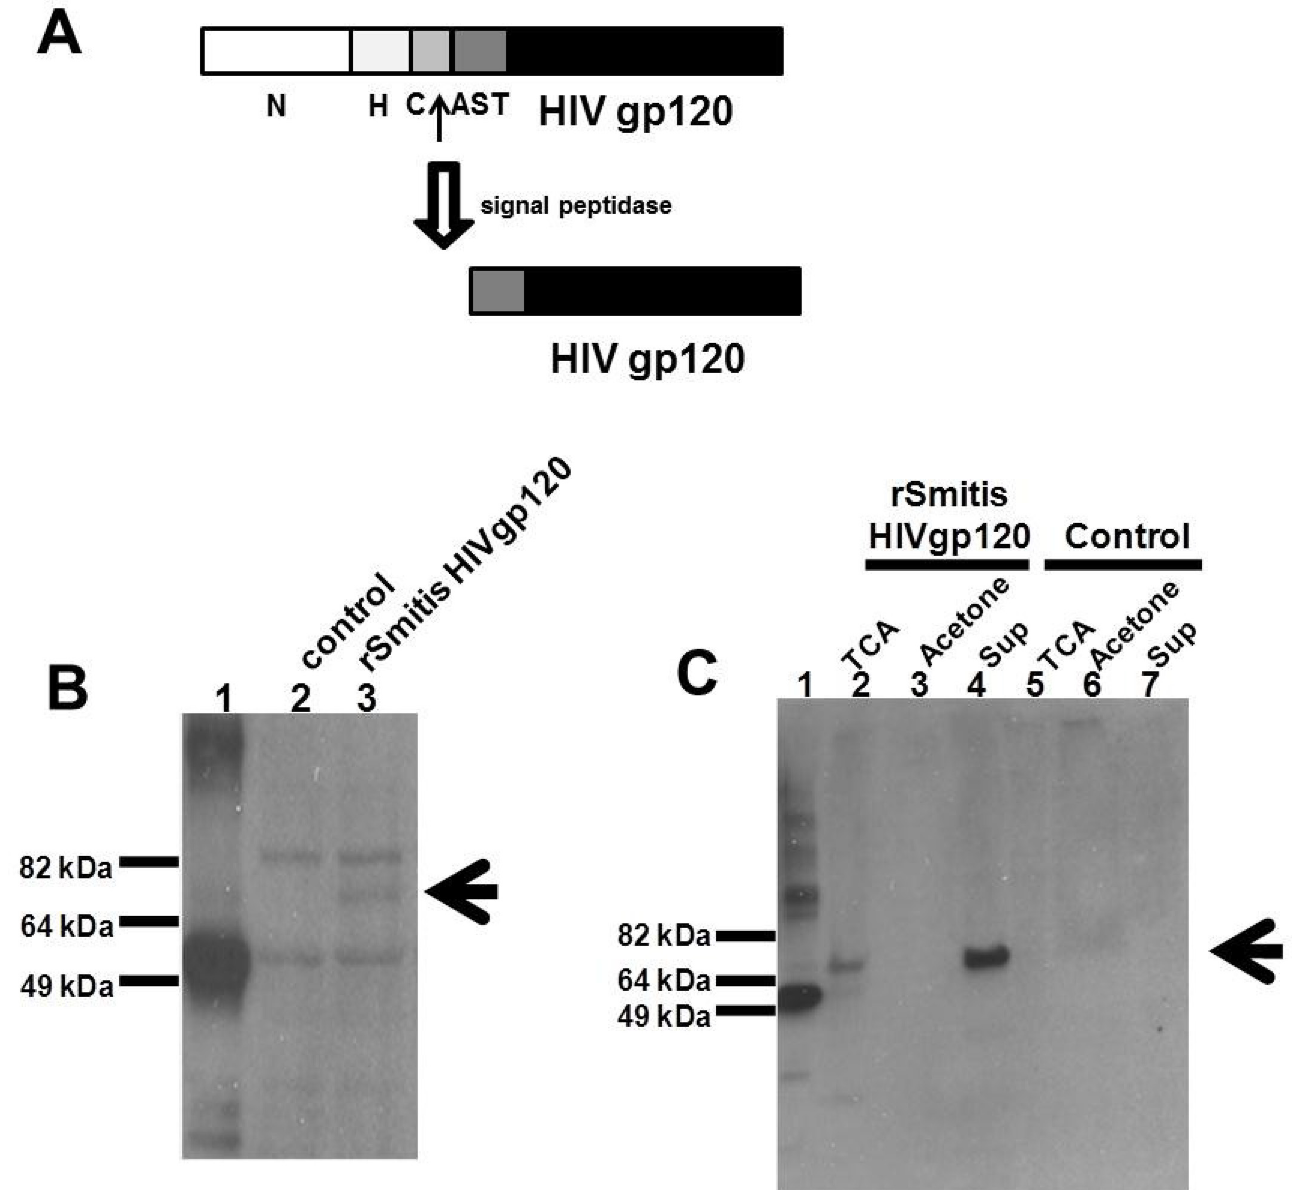
Fig 2. Recombinant S . mitis expresses HIV envelope protein. rS . mitis with the integrated HIV HXBc2 Env gp120 was designed to secrete HIV Env by ligating the HIV Env in frame with 250bp 5 ’ end of the pullulanase gene (pulA/Smt0163) encoding a signal peptide that allows processing and secretion of the HIV antigen. (A) The signal peptide has an amino-terminal region (N), a hydrophobic core (H), a signal peptidase cleavage site (C), and an accessory Sec transport motif (AST). Expression of HIV Env containing a C-terminal His tag was assessed by Western blotting using Penta-His-HRP from a representative recombinant clone in S . mitis lysates (B) and in culture supernatants (C) by TCA-precipitation (TCA), acetone precipitation (Acetone) and Amicon filter- concentration (Sup). HIV Env expression in lysates (B) and supernatants of control S . mitis vector (control) (C) is shown. The arrow denotes expression of the Env Ag band. 100 ng of His-tagged M . tuberculosis protein (MT0401) was used as a positive control (B and C, lane 1). (D) The expression of HIV-1 gp120 in rS . mitis containing the HIV Env gene (lane 2) in Amicon filter-concentrated supernatant was detected using human HIV patient sera. rS . mitis containing the empty plasmid was used as a negative control (lane 1).